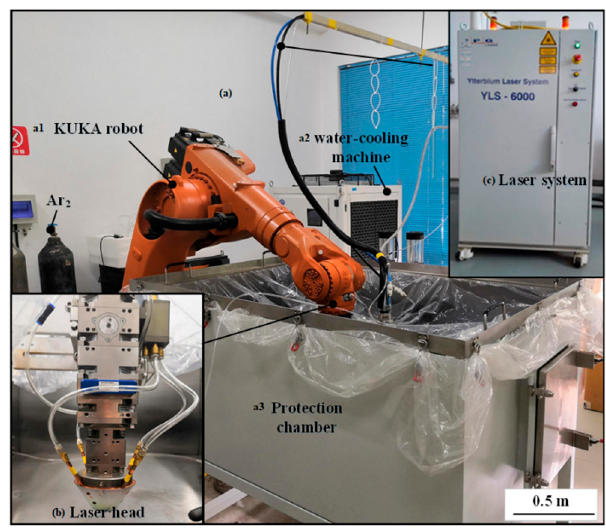
Figure 1. Equipment of laser cladding experiments: ( a ) laser cladding system with a KUKA robot, protection chamber, and water-cooling machine; ( b ) laser head; ( c ) laser system.